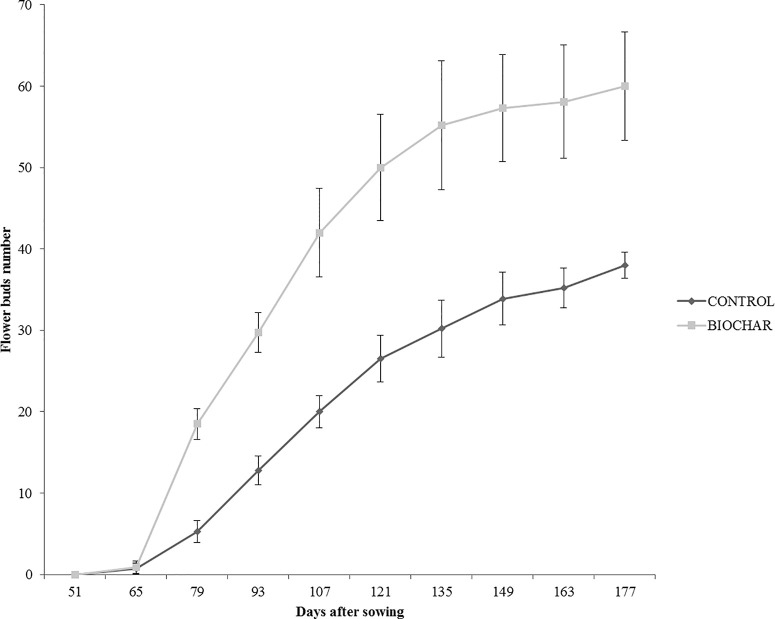
Average number of flower buds in tomato plants experiencing low-input farming conditions in soils amended with or not with 5% Verfofood biochar. Measurements were performed the 50th day after sowing using one sample per five pots.